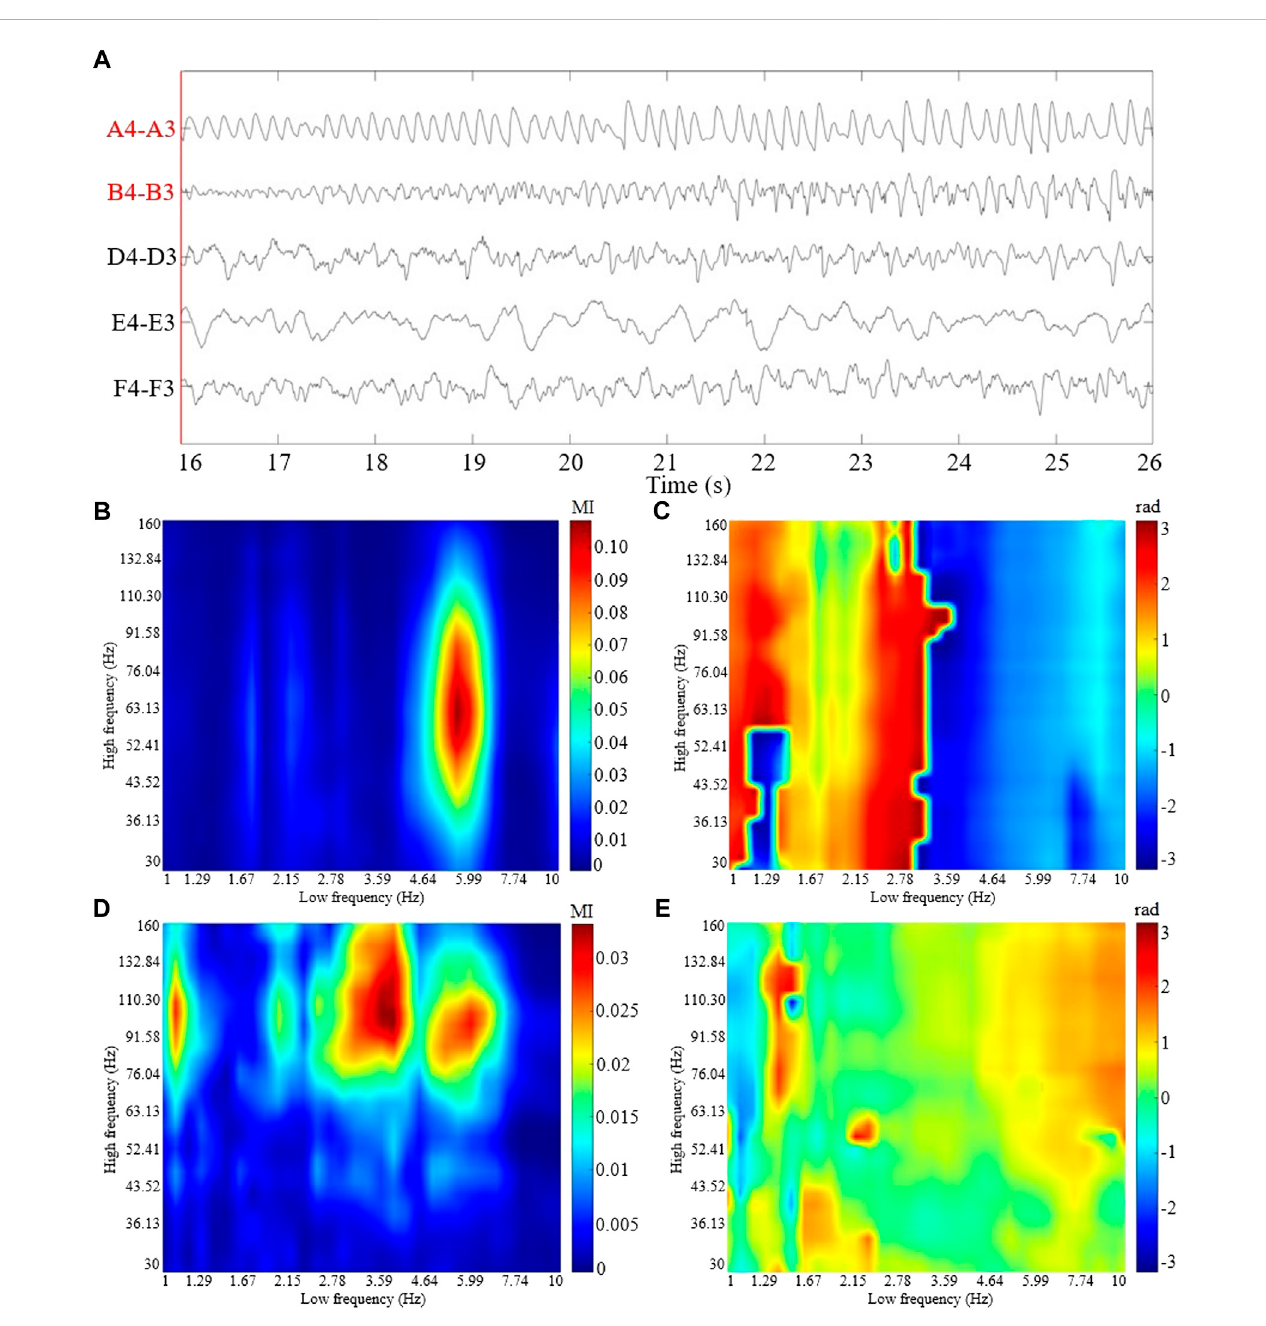
FIGURE 1 TheictalSEEGsegmentandtheCV-PACpatternsfrompatientP1. (A) 10 sSEEGsegmentwithselectedchannels16 safterseizureonset.Thelabelsofthe SEEG channel in surgical resection are marked in red color. (B) The coupling strength of CV-PAC of channel A4-A3 in surgical resection. Red and blue colors indicatestrongandweakcouplingstrengths,respectively.Thevalueisbetween0and1. (C) ThecoupledphaseofCV-PACofchannelA4-A3correspondingto (B) . The range of phase is between − π and π rad. (D) The coupling strength of CV-PAC of channel D4-D3 in the normal brain region. Red and blue colors indicate strong and weak coupling strengths, respectively. (E) The coupled phase of CV-PAC of channel D4-D3 corresponding to (D) . The range of phase is between − π and π